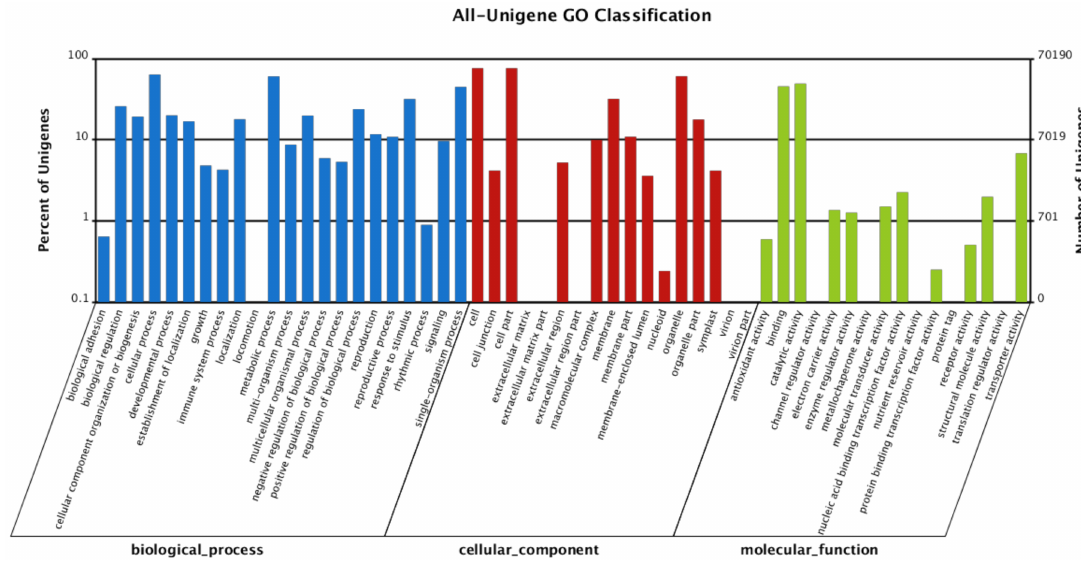
Figure 4. Classification of impatiens unigenes based on the Gene Ontology